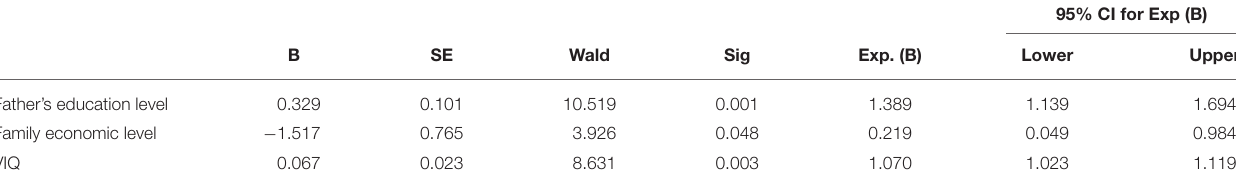
TABLE 4 | Results of the stepwise logistic regression analysis: independent predictors for adult academic outcome in ADHD